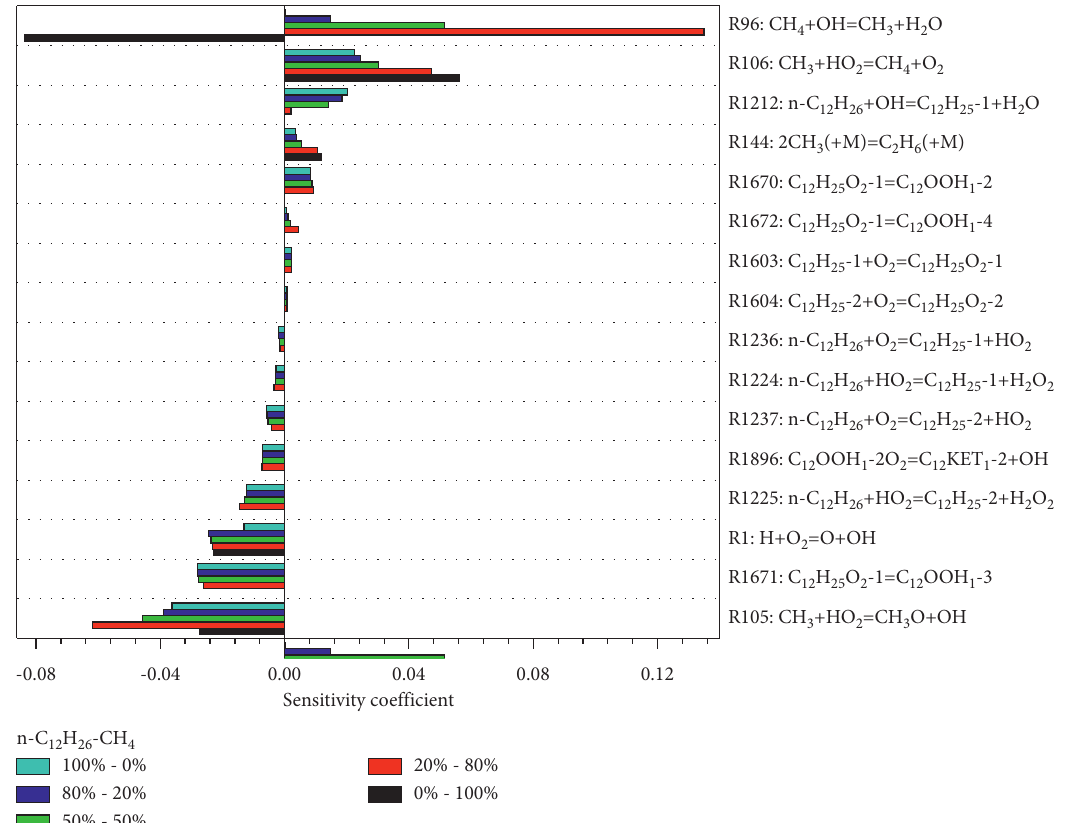
Figure 13: Sensitivity coefficient of ignition delay time for key reactions of methane-n-dodecane at T � 900 K, P � 20bar, and ϕ